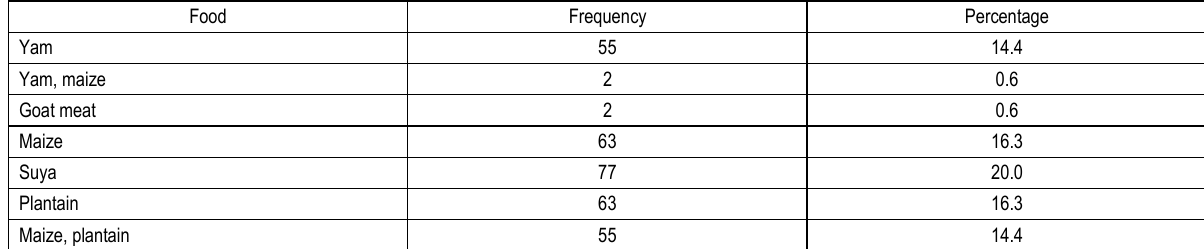
Table 6. Distribution of respondents by the choice of the roasted foods being